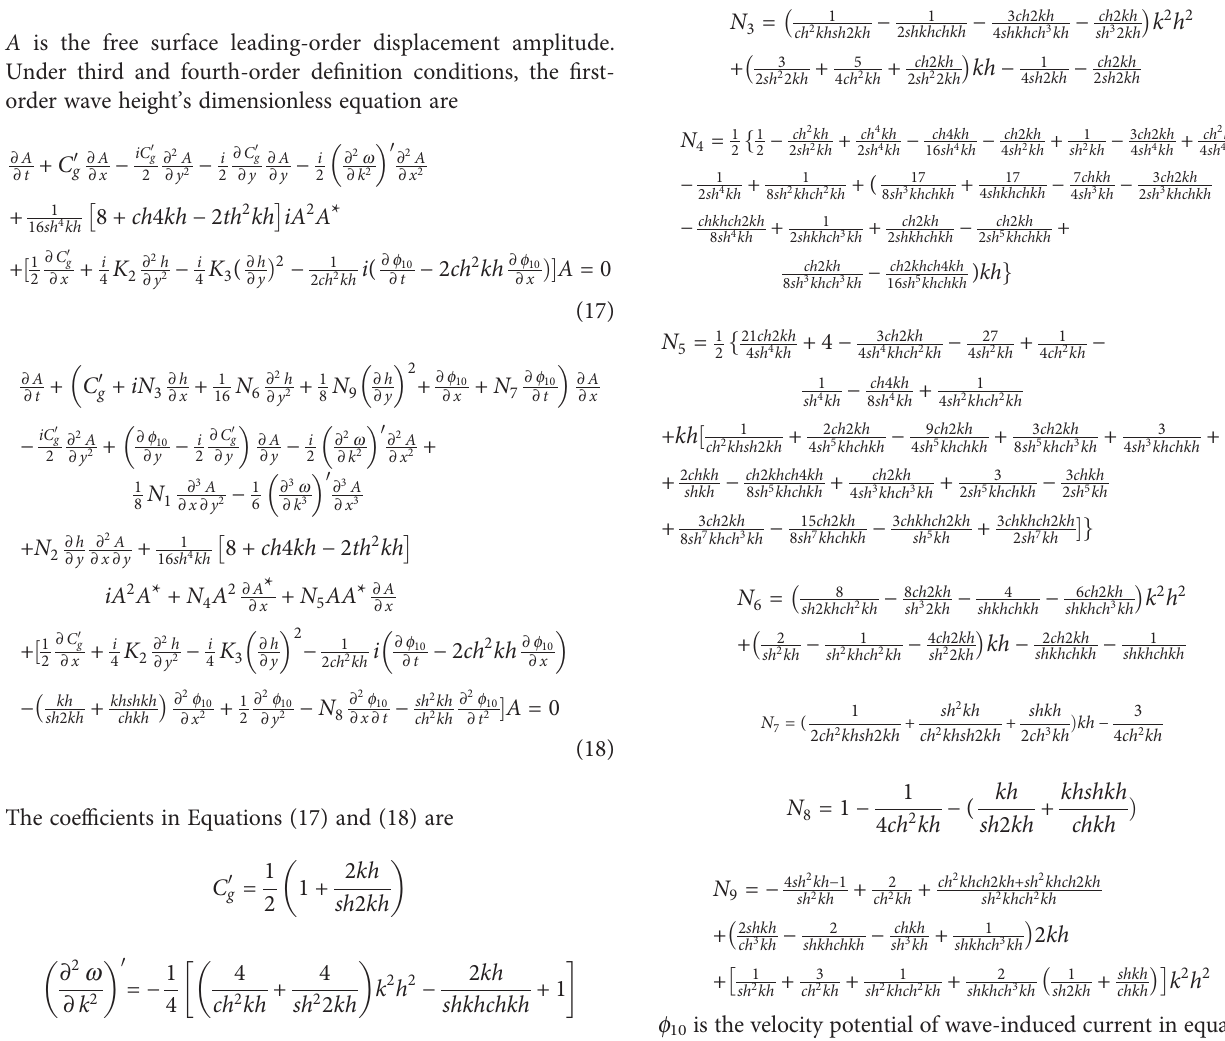
second derivative and the square of the water depth ’ s fi rst derivative affect the fi rst-order wave amplitude when the time scale is longer than e -2 times of the dominant wave period or the space scale is larger than e -2 of the dominant wavelength. Equation (18) is more complicated than Equation (17). incorporating depth variation and wave-induced current terms. are added. Equation (18) indicates that when the time scale